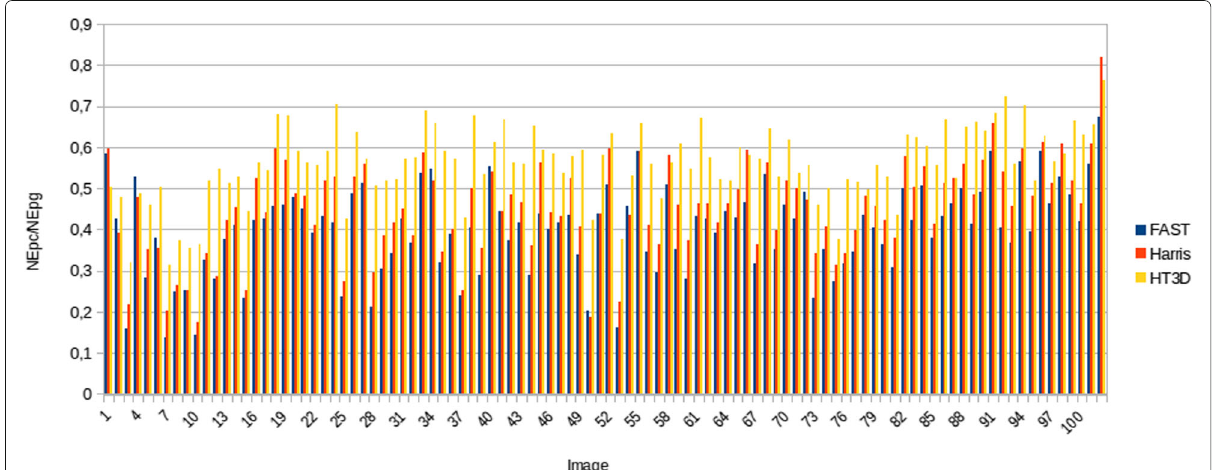
Fig. 18 Ratio between NEp c (number of correct matchings between ground truth and detected points) and NEp g (number of ground truth points) for the whole dataset considering d Ep = 3 (distance between ground truth and detected points). This ratio quantifies the hit rates of the three corner detection methods. In general, clearly higher hit rates can be observed when using the proposed method in the large majority of the test images